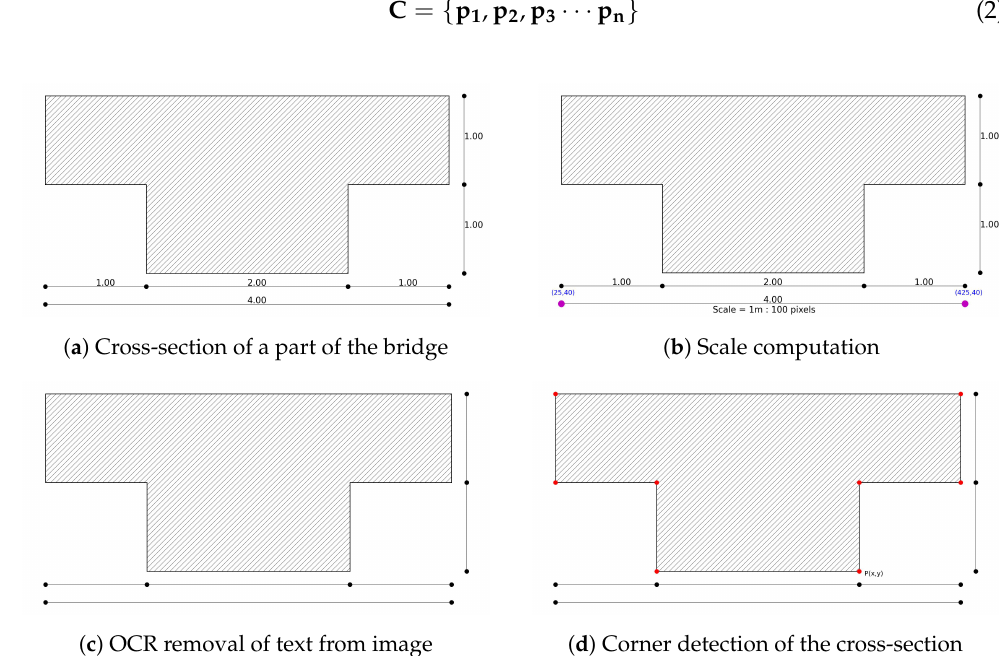
Figure 2. Describes the workflow of the feature extraction. ( a ) is the cropped-out image; ( b ) explains the scale computation from the pixel coordinate system and a metric coordinate system; ( c ) shows the result after removing the text from the image using OCR; the red dots in ( d ) indicate the corners P ( x , y ) of the